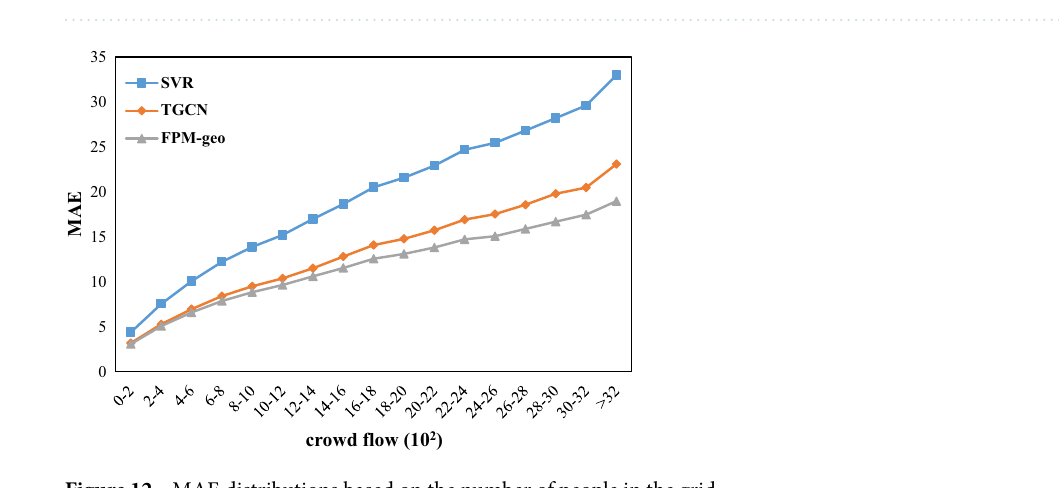
Figure 11. Spatial distributions of the MAPE differences among different models: ( a ) FPM-geo and SVR; ( b ) FPM-geo and TGCN.